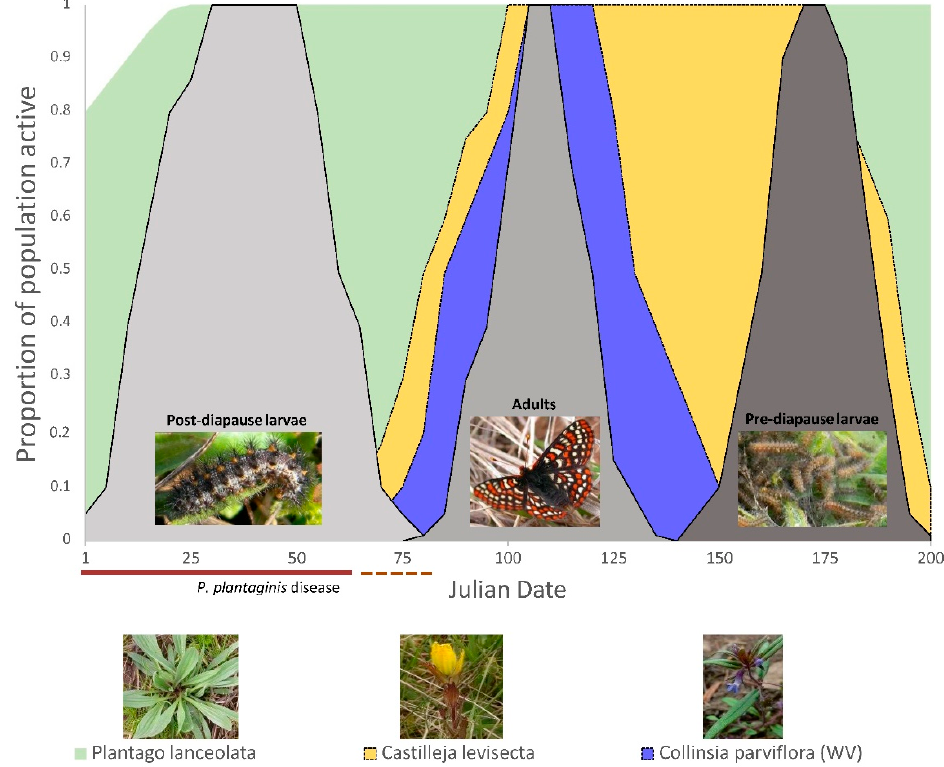
Figure 2. Temporal profiles of plantain-dependent Taylor’s checkerspot butterfly development and host plant availability arranged by Julian date in Oregon, USA populations. Relative abundance of butterflies (gray shaded areas) and host plants (green = Plantago lanceolate —plantain, blue = Collinsia parviflora , yellow = Castilleja levisecta ) are represented as the proportion of the total observed for that life stage (butterflies) or monitored plant populations. P. plantaginis disease occurrence is indicated by the bar below the x -axis where the time period with the most severe disease (>50% of diseased plants with >50% foliar necrosis) is represented by a solid brown line and a dotted brown line represents the transition period from severe disease (>50% necrosis covering the entire leaf crown of infected plants) to no disease.